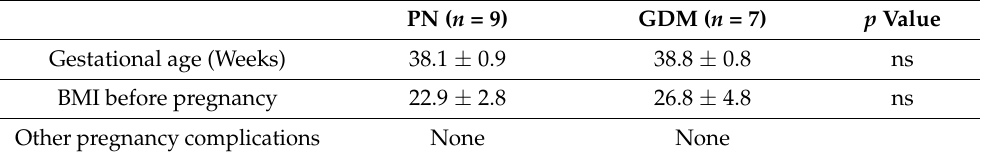
Table 1. Clinical features of normal and GDM pregnancies. Samples were matched based on gesta- tional age, body mass index (BMI) before pregnancy as well as the absence of other pregnancy com- plications. Gestational age and BMI are shown as mean ± SD. ns denotes not statistically significant. PN ( n =